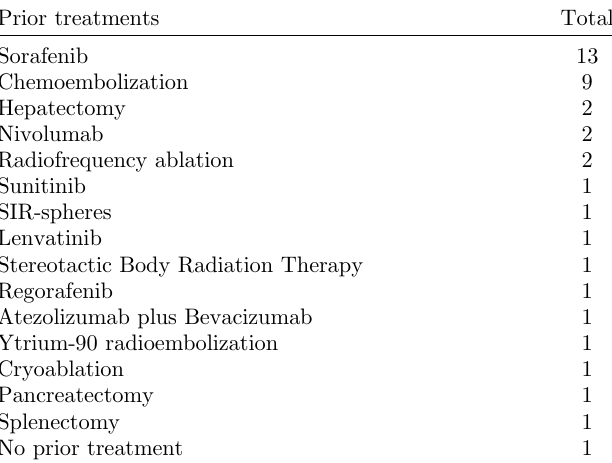
Table 2. Treatment received by real-world patients prior to treatment with the TheraBionic device. The Table reports the number of patients who received systemic and locoregional treatments prior to treatment with the TheraBionic